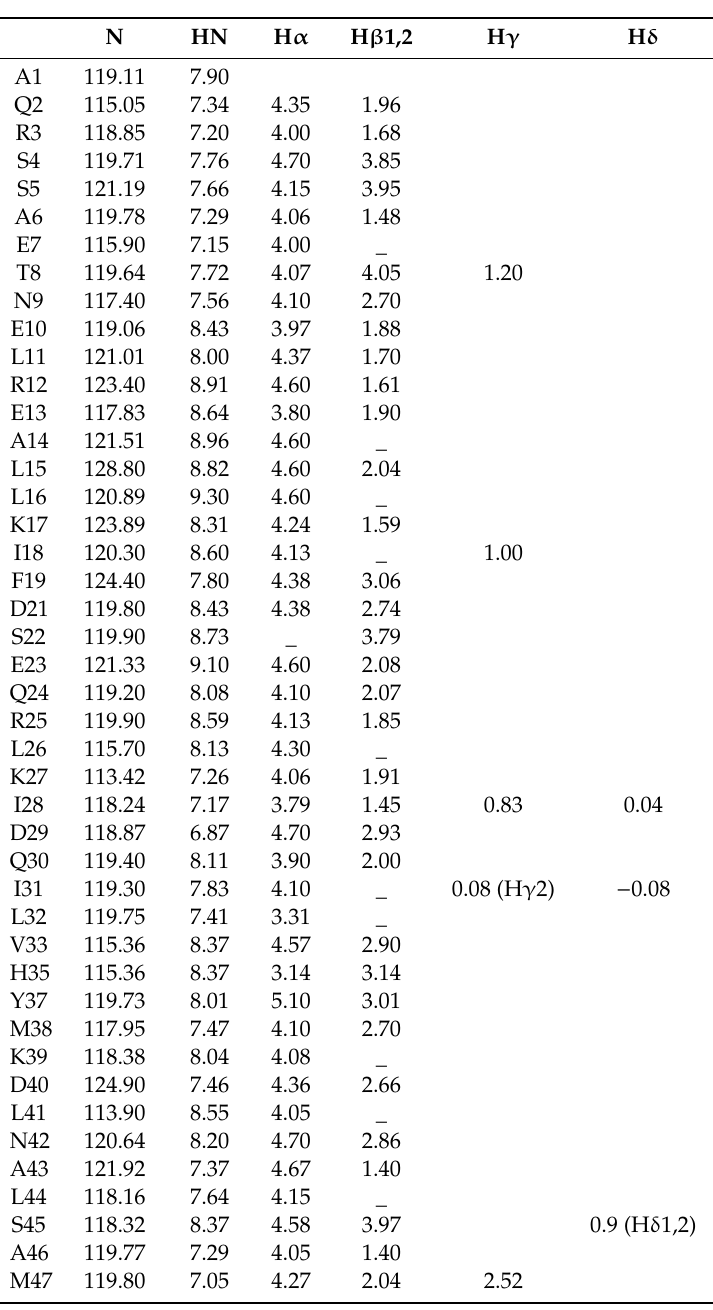
Table 1. Chemical shift assignments of resonances of 1 H and 15 N nuclear magnet resonance (NMR)